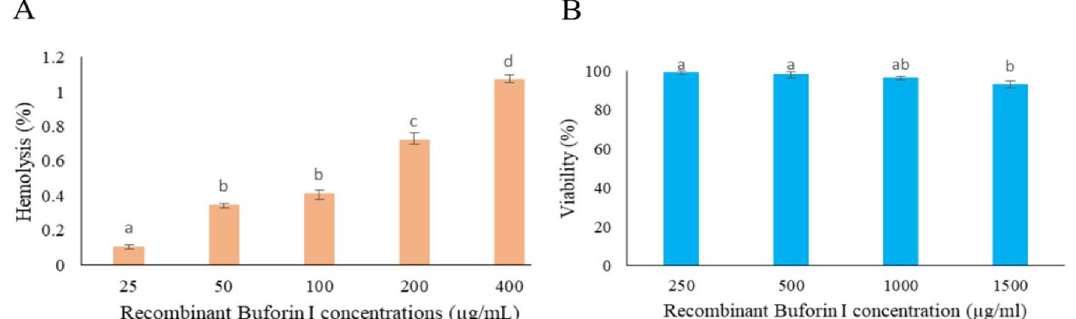
Figure 8. ( A ) Evaluation of hemolytic and ( B ) cytotoxic effects of recombinant buforin I on human blood hemoglobin and human fibroblast cell line, respectively. Different lowercase letters indicate significant difference ( p < 0.05).